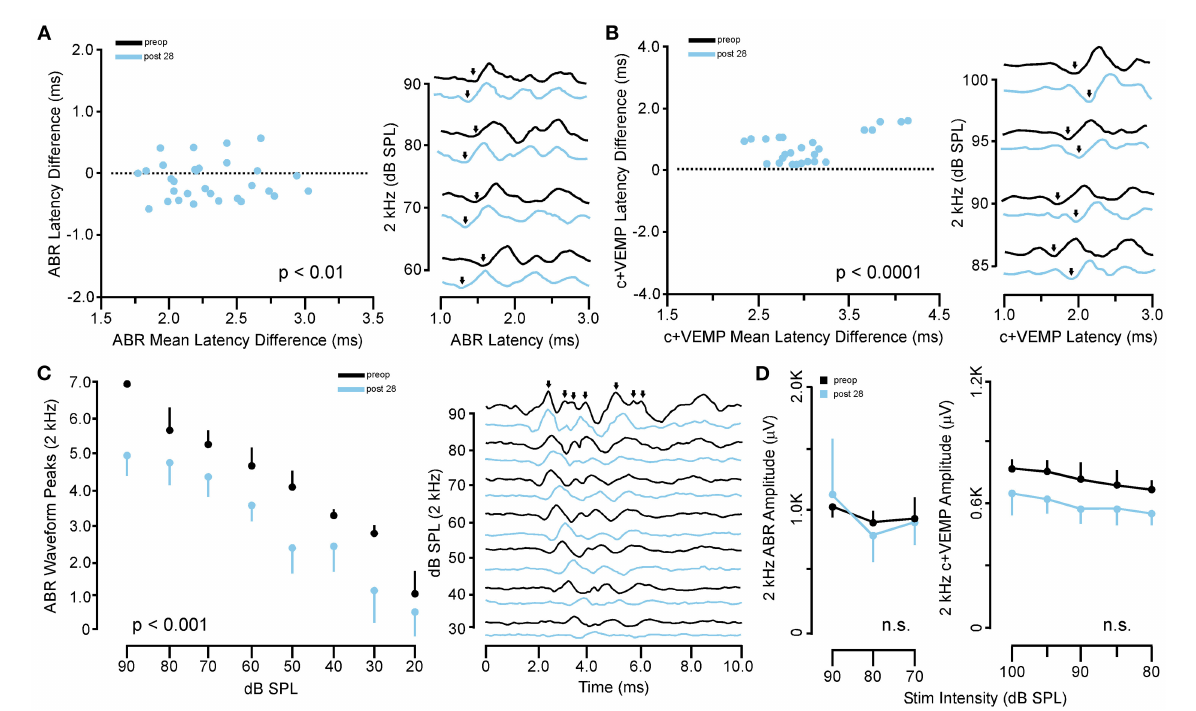
FIGURE4 Persistent changes to ABR and c + VEMP waveform latency and expression after recovery from SSCD. (A) Scatterplot (left) showing the matched pair analysis of wave 1 ABR latency before SSCD (preoperative) and after recovery for the large SSCD group (post-SSCD 28) SSCD groups. A representative example of the persistent increase in ABR latency is shown on the right. (B) Scatterplot (left) showing the matched pair analysis of wave 1 c + VEMP latency before SSCD (preoperative) and after recovery for the large SSCD group (post-SSCD 28). A representative example of the persistent decrease in c + VEMP latency is shown on the right. (C) Line plot (left) comparing the average number of ABR waveform peaks present for 2kHz stimuli at each dB SPL before (preoperative) and after recovery for large SSCD group (post-SSCD 28). Diagram (right) showing a representative example of ABR waveforms for 2kHz stimuli before (preoperative) and after recovery (post-SSCD 28, dashed line) from large SSCD. (D) Left, line plot comparing ABR amplitudes between preoperative baselines and end point recordings for large SSCD group (post-SSCD 28) at 2kHz stimulation levels. Right, line plot comparing c + VEMP amplitudes between preoperative baselines and end point recordings for large SSCD group (post-SSCD